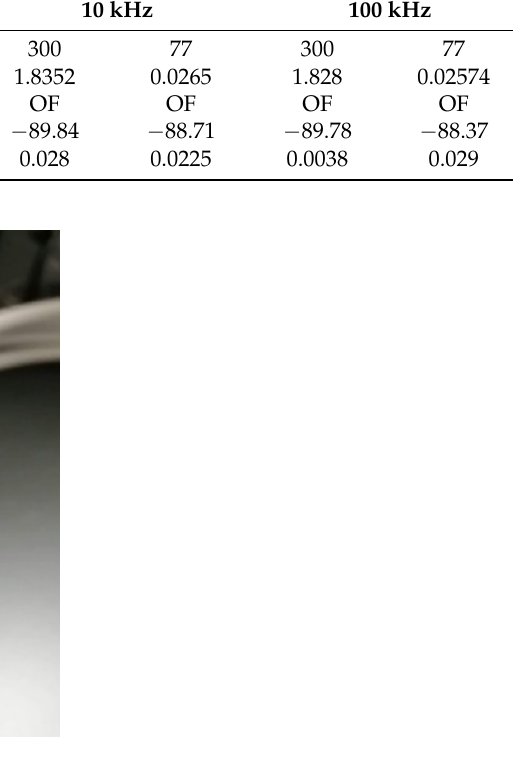
Figure 11. Mechanical failure (breakage) in the ceramic capacitor during the experimental testing.